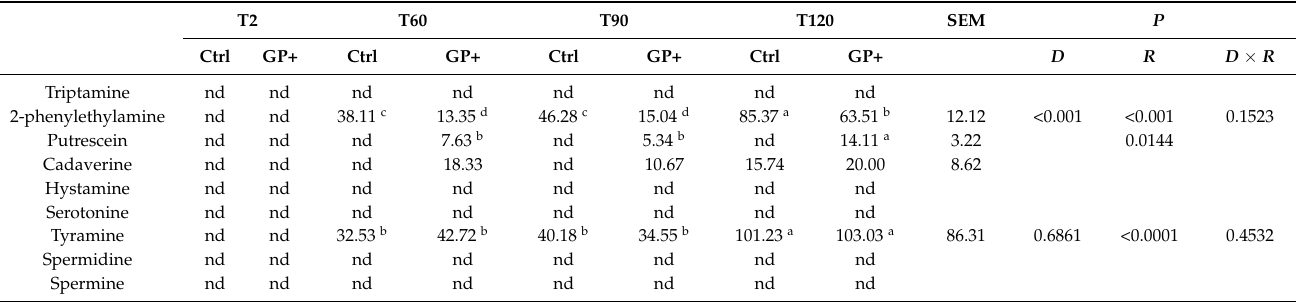
Table 2. Concentrations of biogenic amines in cheese after 2 (T2), 60 (T60), 90 (T90) and 120 (T120) days of ripening, obtained from raw milk of ewes fed standard diet (Ctrl) and grape pomace diet